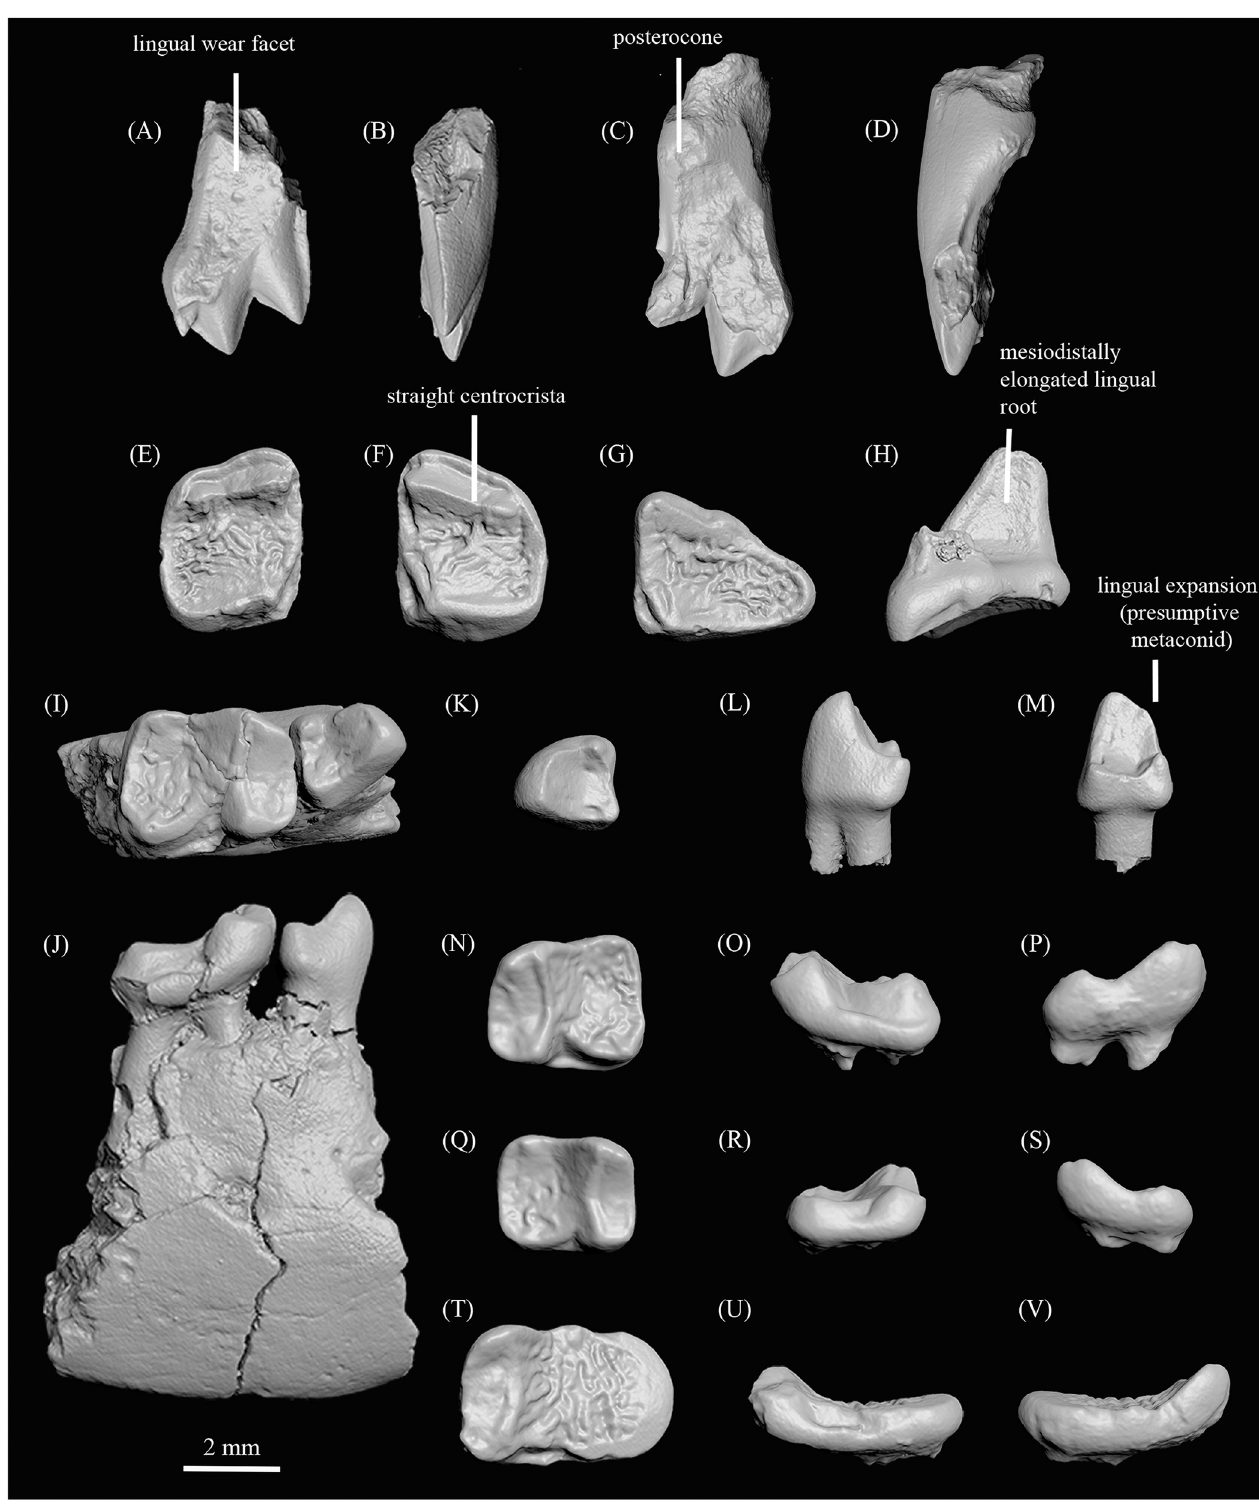
Fig 4. Dentition of Ignacius dawsonae sp. nov. from Ellesmere Island, Nunavut, Canada. A, B, CMN 32325, apical fragment of right I 1 in lingual ( A ) and distal ( B ) views; C, D, CMN 30903, left I 1 in lingual ( C ) and distal ( D ) views; E, CMN 32320, right M 1 in occlusal view; F, CMN 30868, left M 2 in occlusal view; G, H, CMN 32321, left M 3 in occlusal ( G ) and buccal ( H ) views; I, J, CMN 30837 (holotype), right dentary fragment with P 4 -M 1 in occlusal ( I ) and buccal ( J )